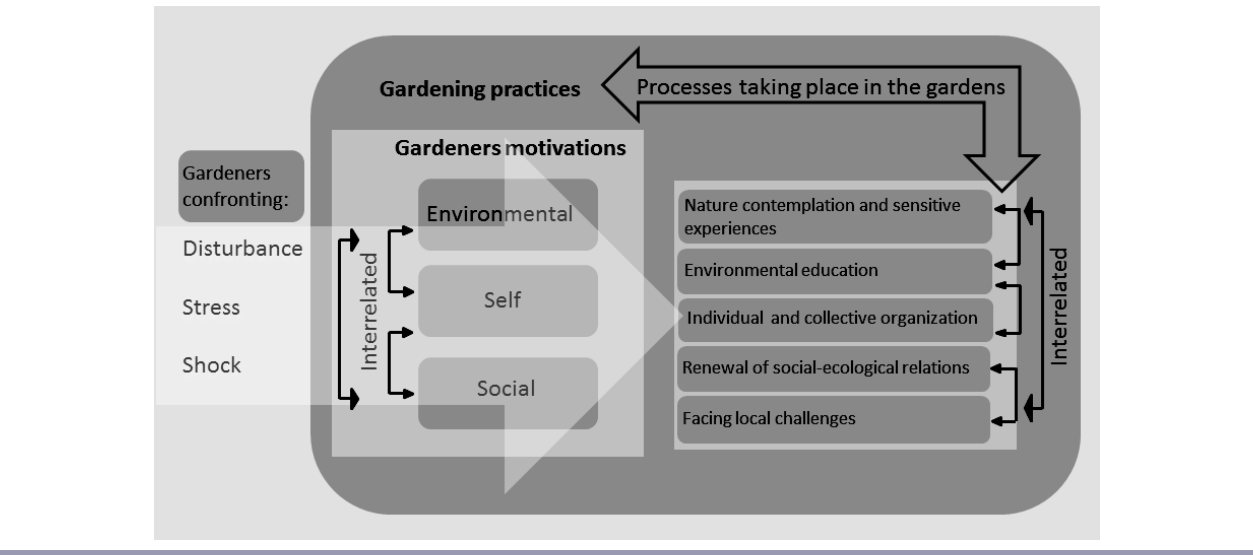
Fig. 2 . Schematic representations of social–ecological dynamics in French community